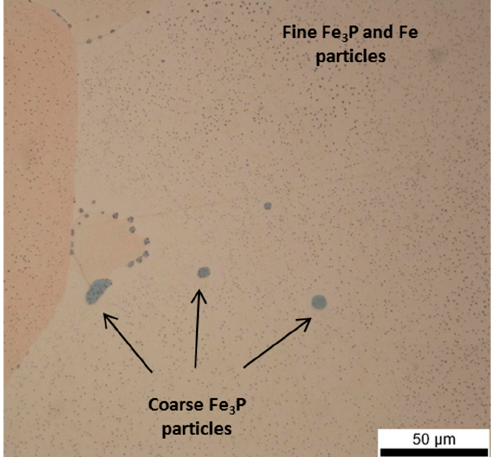
Figure 1. Microstructure of Cu–Fe–P alloy. Fe 3 P particles appear with size ranging from 1–10 μ m preferably at grain boundaries whereas Fe particles are homogeneously distributed in the Cu matrix.